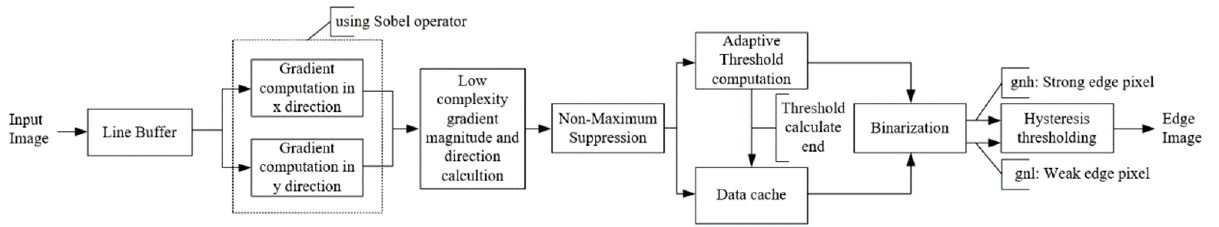
Figure 2. Architecture of improved Canny edge detection.